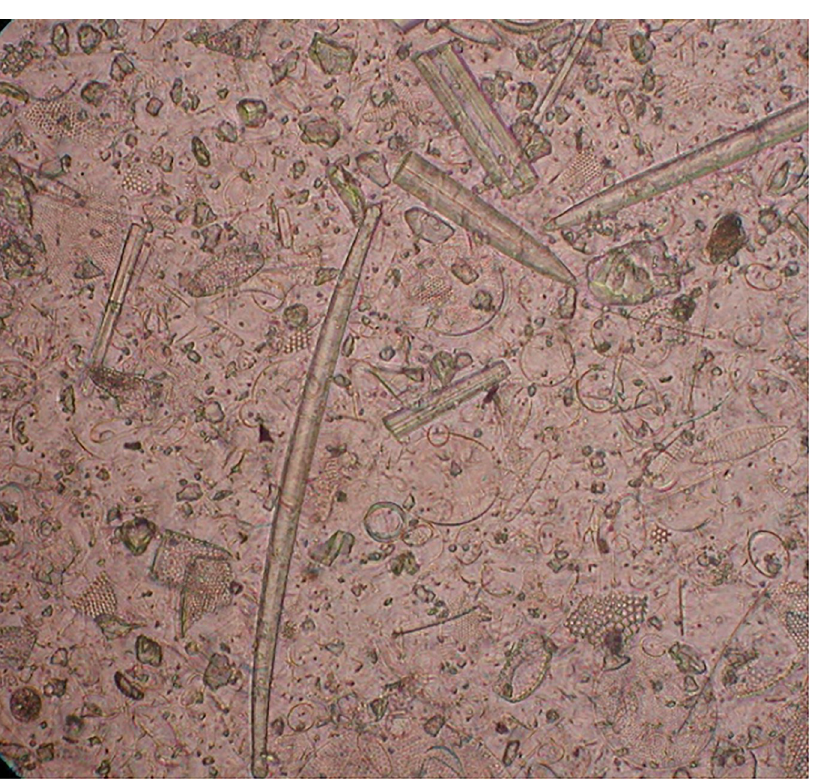
Fig 3. Example of a diatom sample (under light microscope) contaminated with aluminosilicates and sponge spicules. Sample from the Southern Ocean [17].